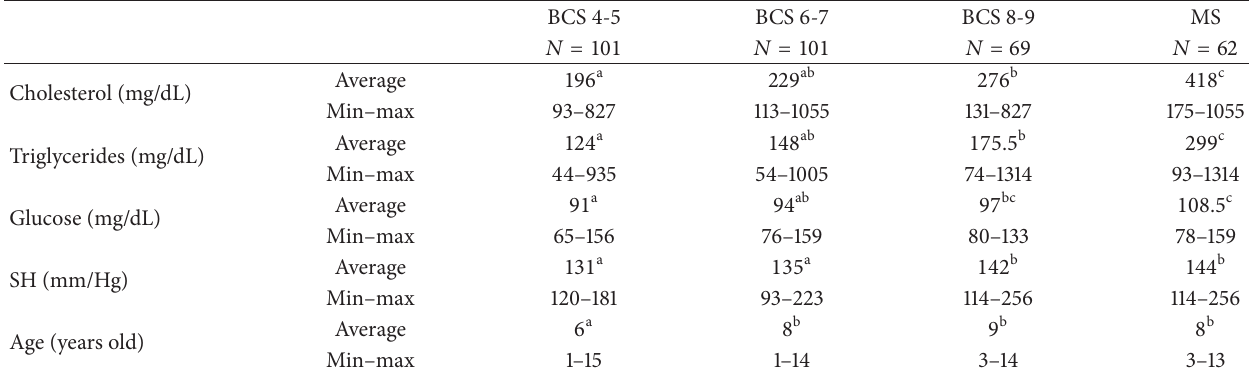
Table 1: Median, minimum, and maximum values and number of observations ( 𝑁 ) in 271 dogs grouped according to the BCS and inclusion criteria for metabolic syndrome.